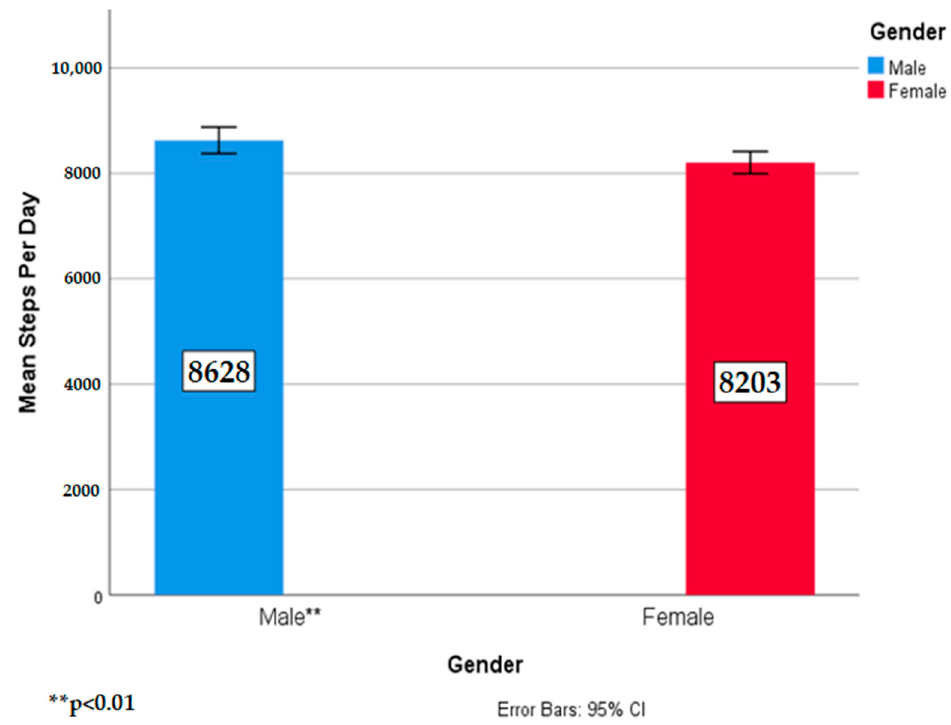
Figure 4. Means and standard deviations of steps per day by